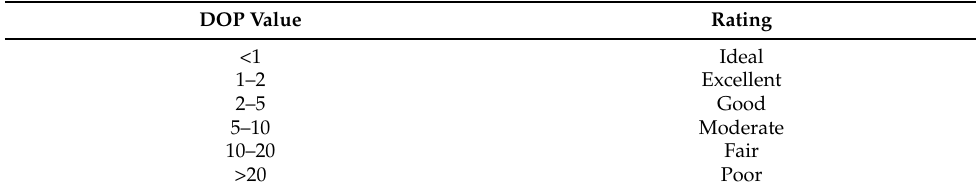
Table 6. DOP value rating